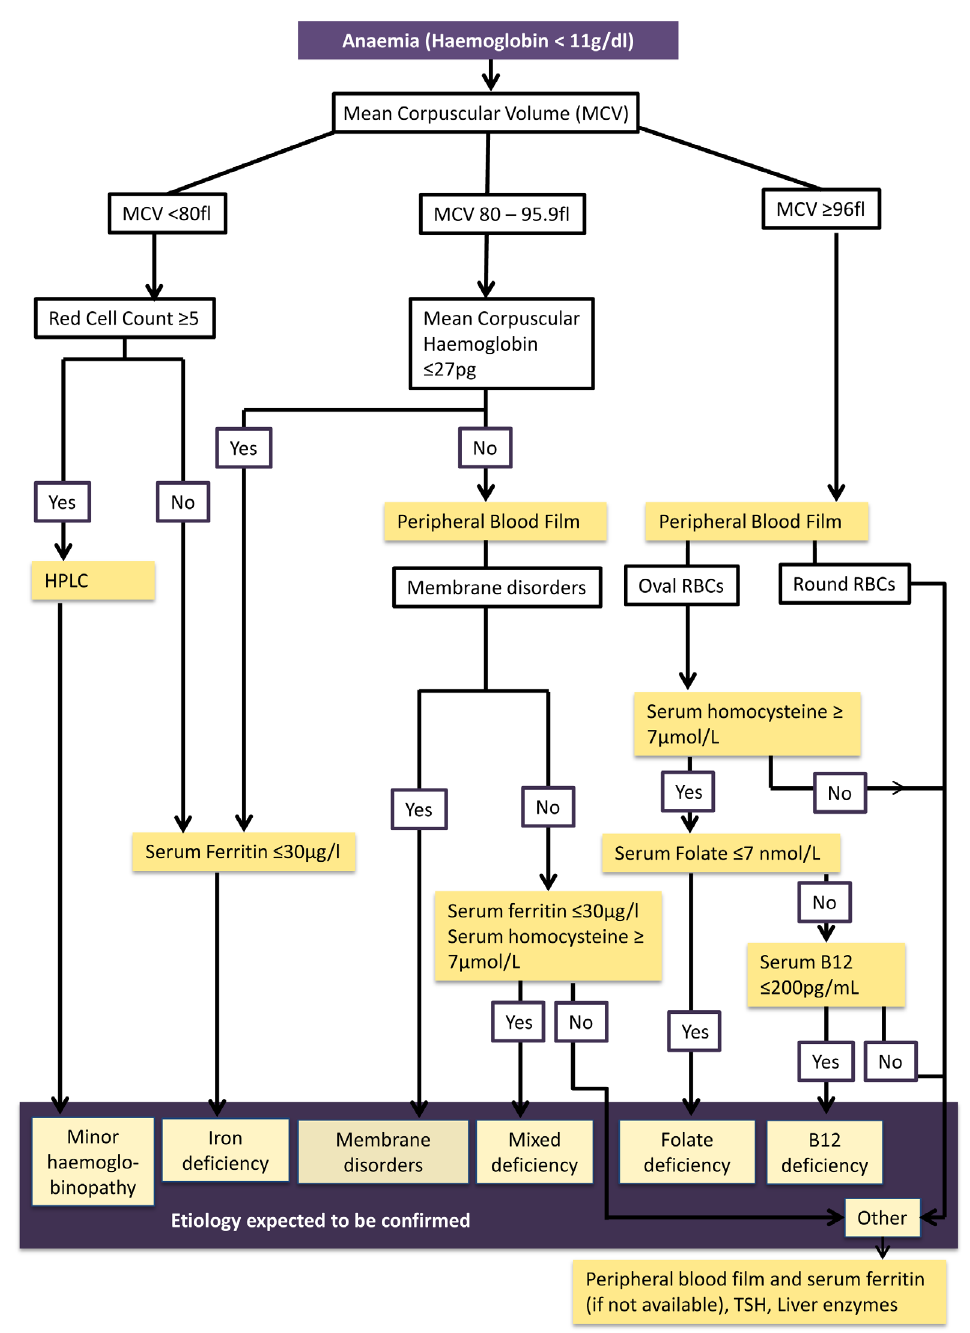
Figure 2. Algorithm for investigating etiology of anaemia among first trimester pregnant women in Anuradhapura district. This figure shows the evidence-based algorithm developed to guide the laboratory investigations to determine etiology of anaemia among first trimester pregnant women in the Anuradhapura district. Anaemia is determined by haemoglobin level less than 11 g/dl. Anaemia will be further classified as mild (10 – 10.9 g/dl) moderate (7–9.9 g/dl) and severe (<7 g/dl) based on the WHO classification. Mean corpuscular volume is used to identify microcytic (MCV less than 80 fl), normocytic (MCV 80 to 95.9 fl) and macrocytic anaemia (MCV more than 96). Those who have microcytic anaemia with high red cell counts (five or more*10 6 /µl) will be tested for minor haemoglobinopathies using HPLC testing. Those who have microcytic anaemia with normal red cell counts or have normocytic anaemia with mean corpuscular haemoglobin (MCH) 27 pg or less will undergo serum ferritin testing to determine iron deficiency. A peripheral blood film of participants with normocytic anaemia with MCH more than 27 will be examined to see if there are membrane disorders. Then serum Homocysteine and ferritin will be estimated in them to determine mixed deficiency. If this etiology is not confirmed with these investigations, thyroid stimulating hormone (TSH) and liver enzymes will be tested along with ferritin assessment. A peripheral blood film will be examined in macrocytic anaemic participants. If macrocytes are round, serum Homocysteine will be estimated. If it is raised, serum folate and B12 levels will be conducted to determine which nutrient is deficient. If oval macrocytes are present, TSH, liver enzymes and serum ferritin will be assessed.